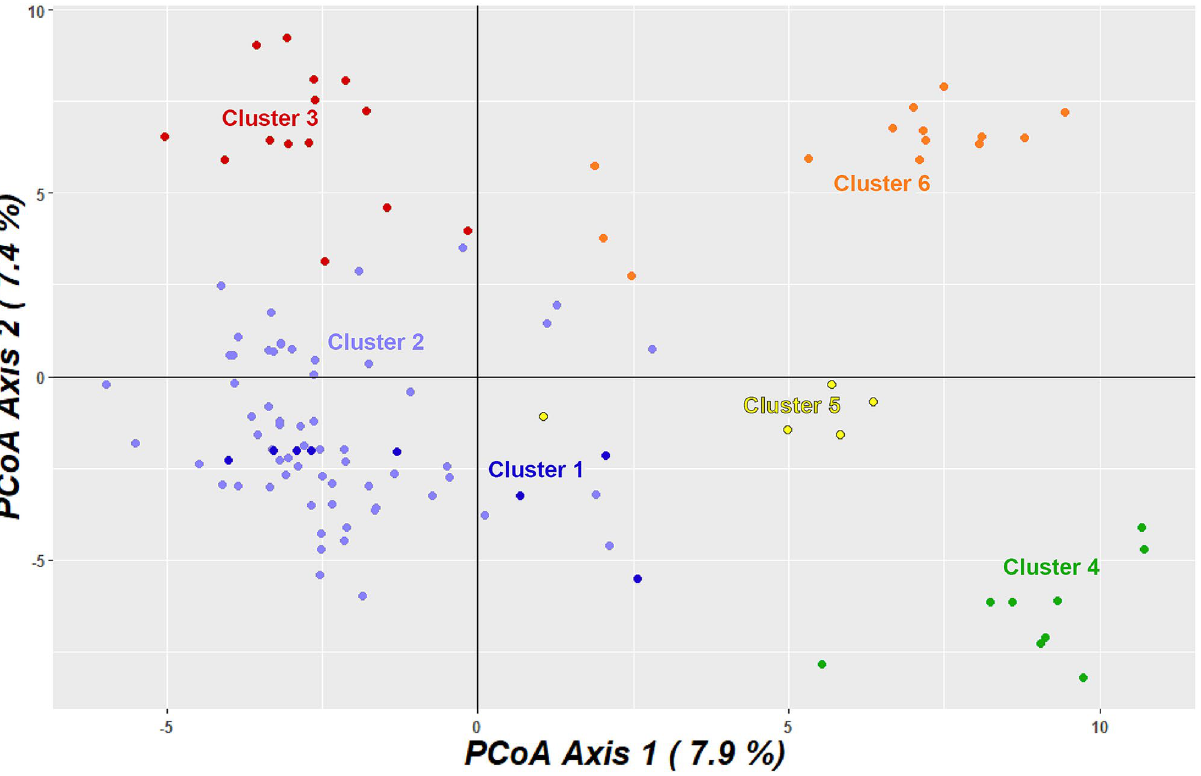
Figure 4. Principal coordinate analysis (PCoA) of 112 Luffa acutangula accessions using DArTseq-based SNPs.